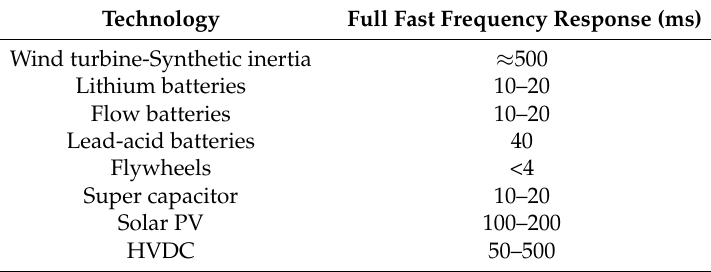
Table 9. Activation time of non-synchronous technologies